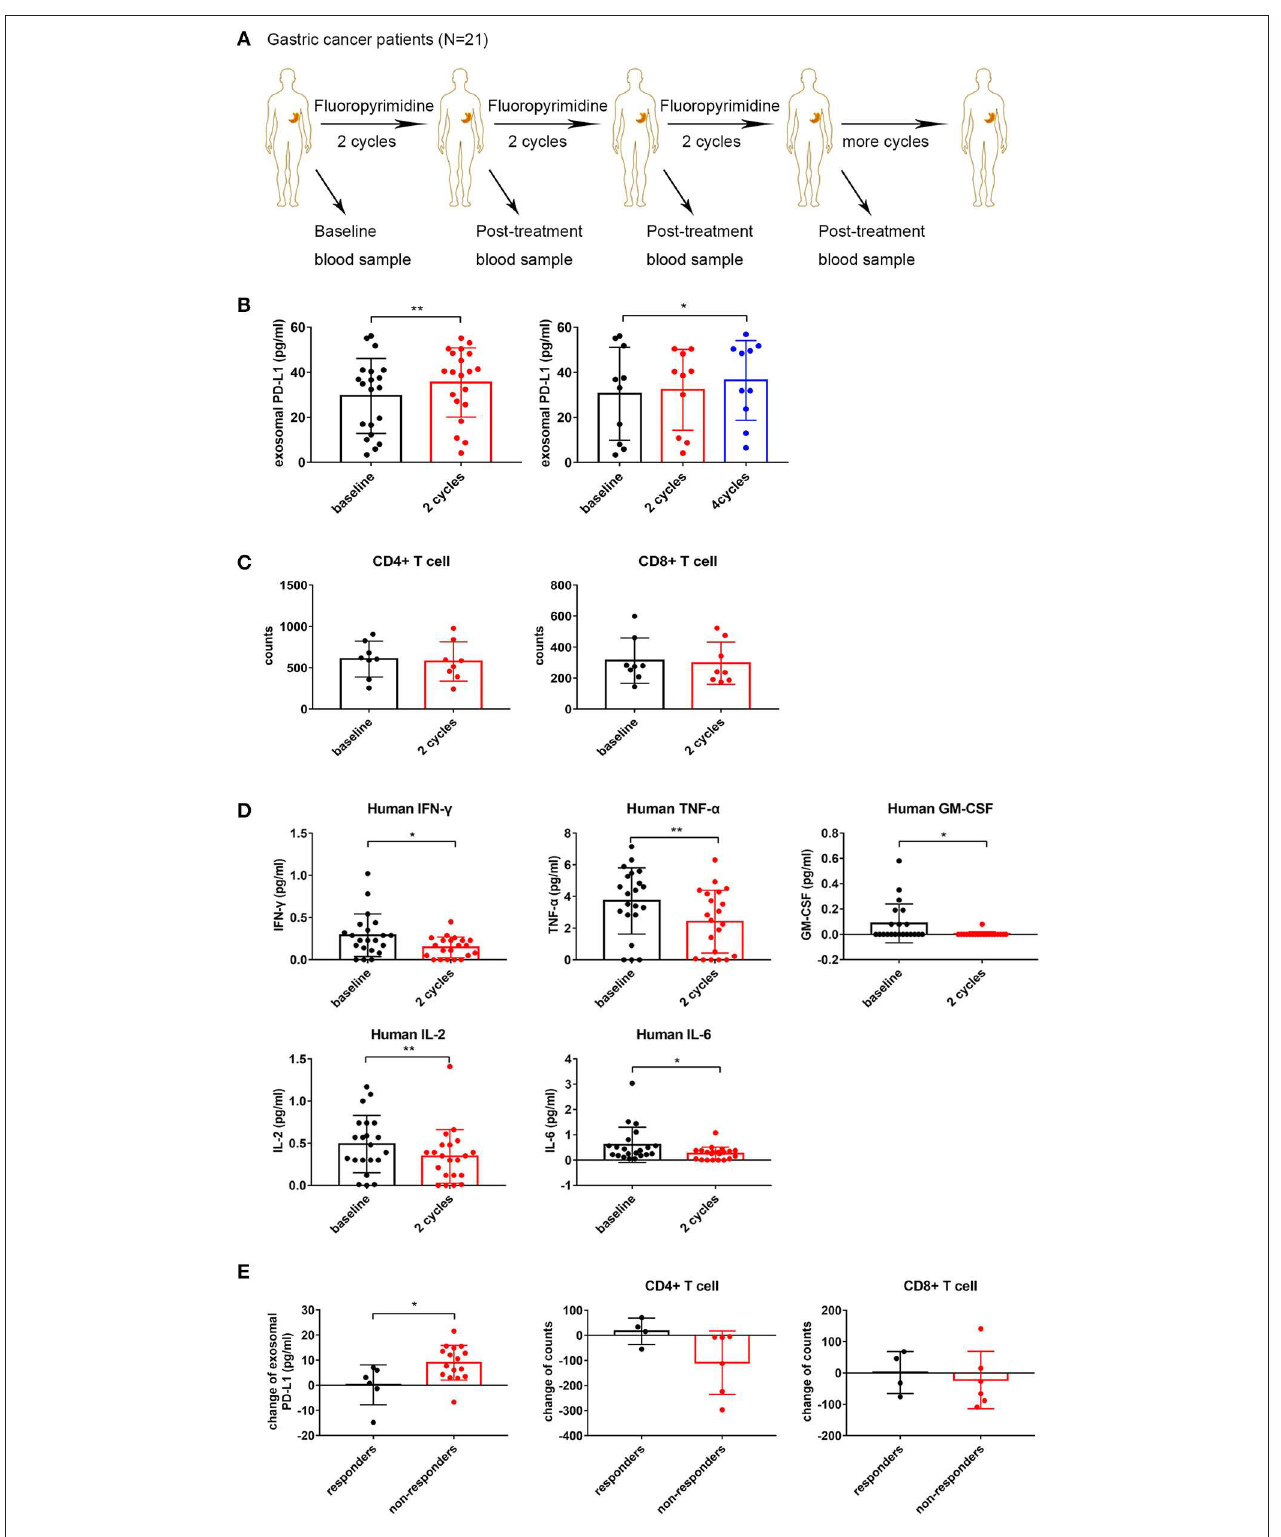
FIGURE 3 | Fluoropyrimidine increases circulating exosomal programmed death-ligand 1 (PD-L1) in gastric cancer patients. (A) Schematic illustration of blood samples collection at baseline and after two, four, and six repeated cycles of fluoropyrimidine chemotherapy treatment from stage III–IV gastric cancer patients